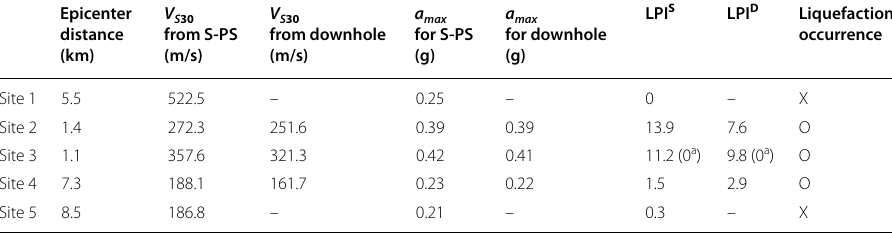
Table 1 Epicentral distances, V for